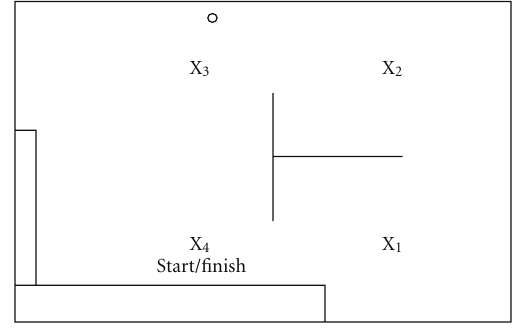
Figure 4: The experiment room (9.6m × 6.2 m) with four waypoints was equipped with ground truth positioning sensors.